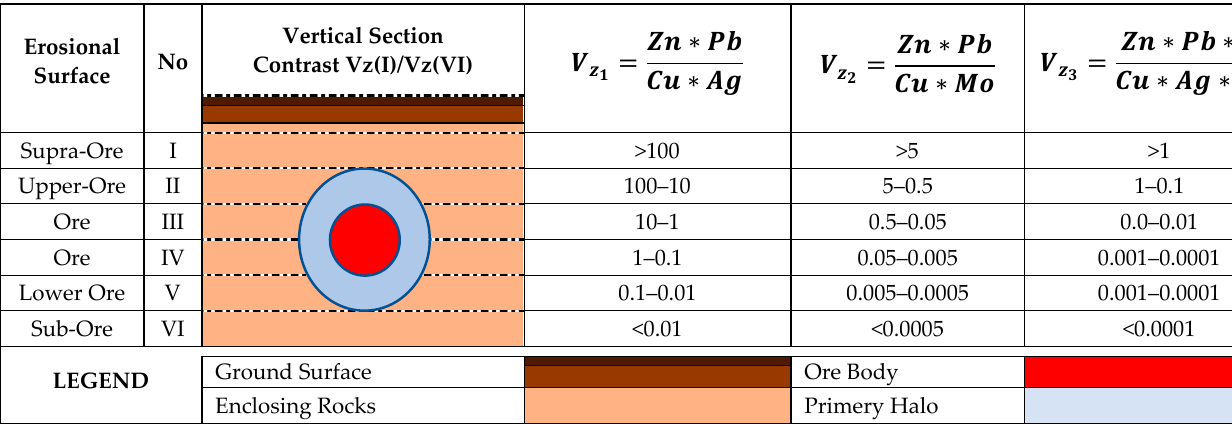
Table 1. The types of Vz index for identifying the erosional surface of Cu porphyry deposits (deposits from iran, Kazakhstan, Armenia and Bulgaria) [44].